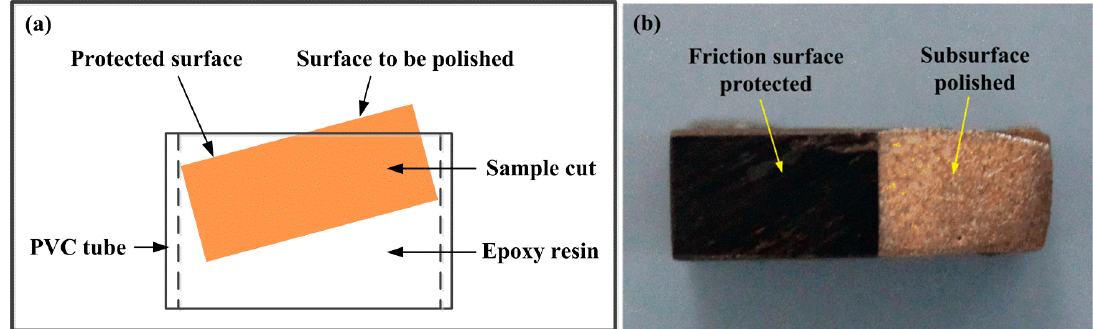
Figure 4. Schematic of inlaid sample ( a ) and inclined-plane sample ( b ).